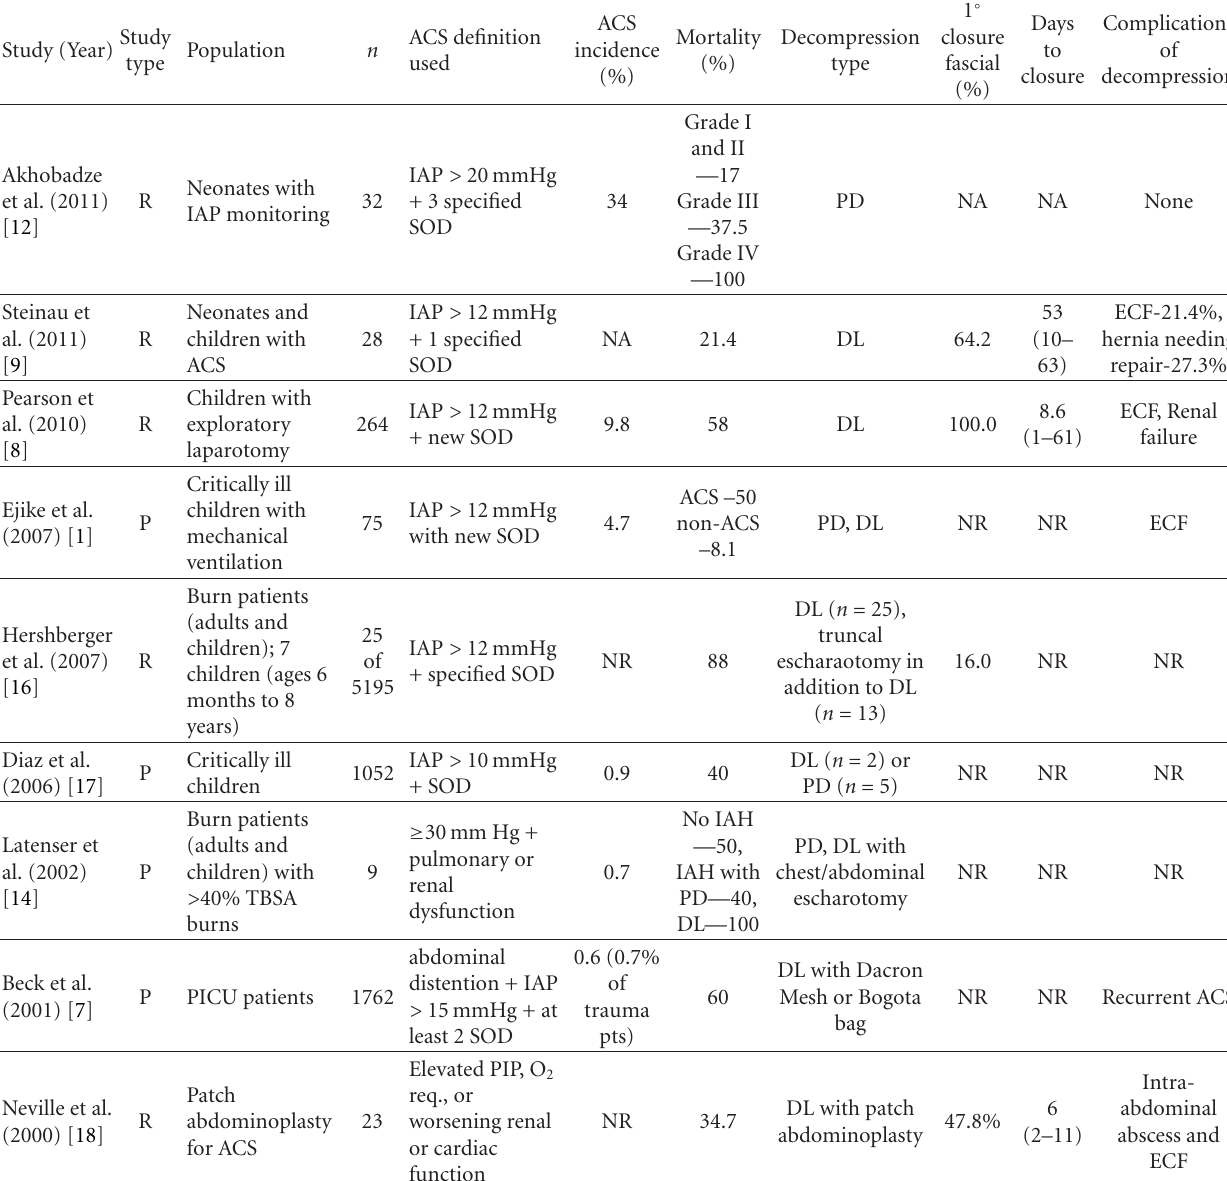
Table 1: Reported clinical experience with abdominal decompression in